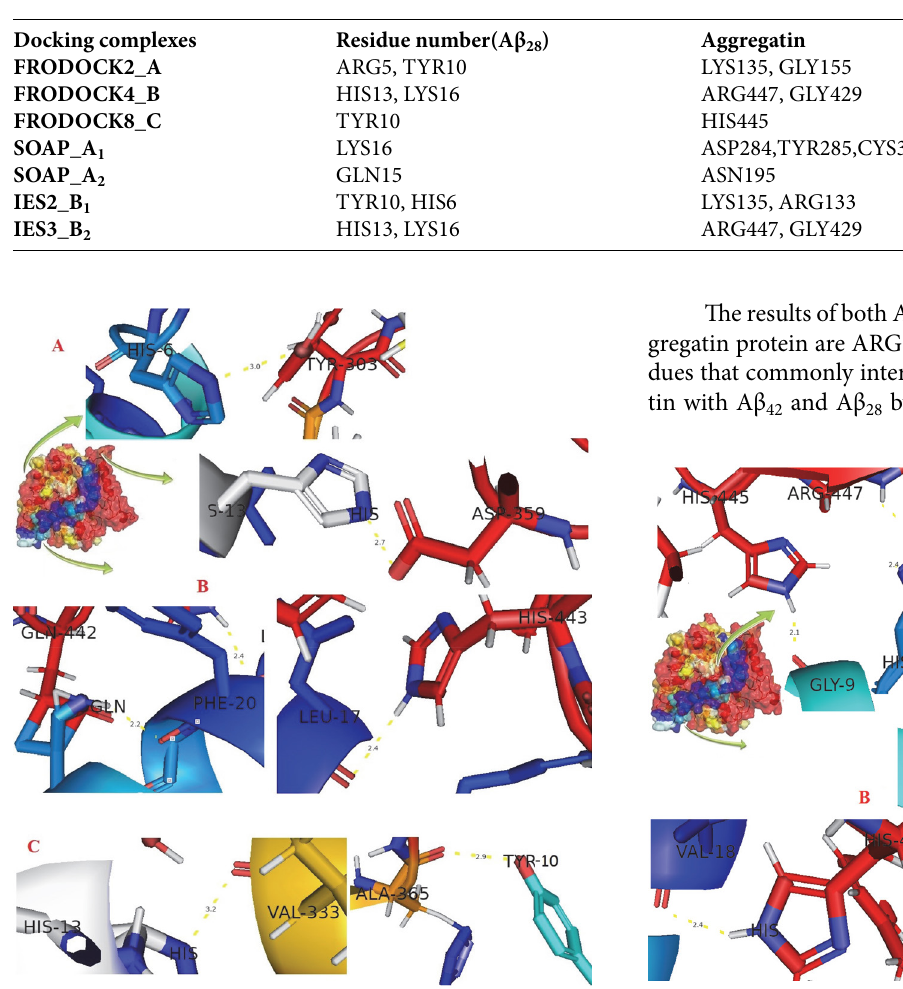
Table 3. The interface residues on each protein between the model of Aggregatin and Aβ 28 peptides. IES and FRODOCK2 score (higher is better), SOAP_PP score (lower is better).